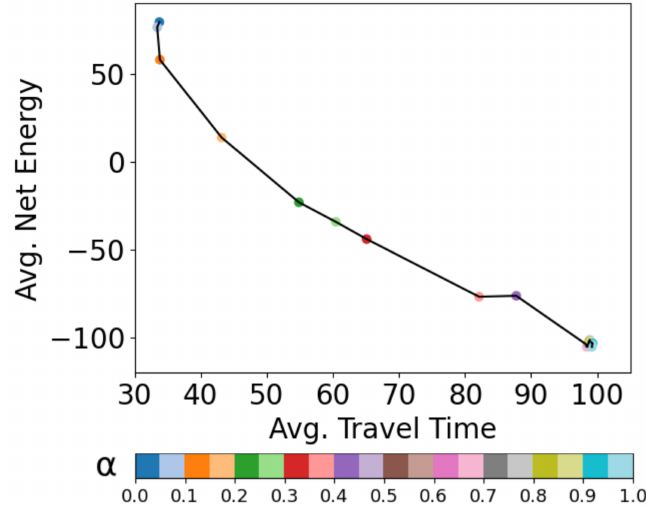
Figure 5. Expected Travel Time vs. Net Energy operating curve for optimal time and net energy missions. Each point is for an α value colored as per the color